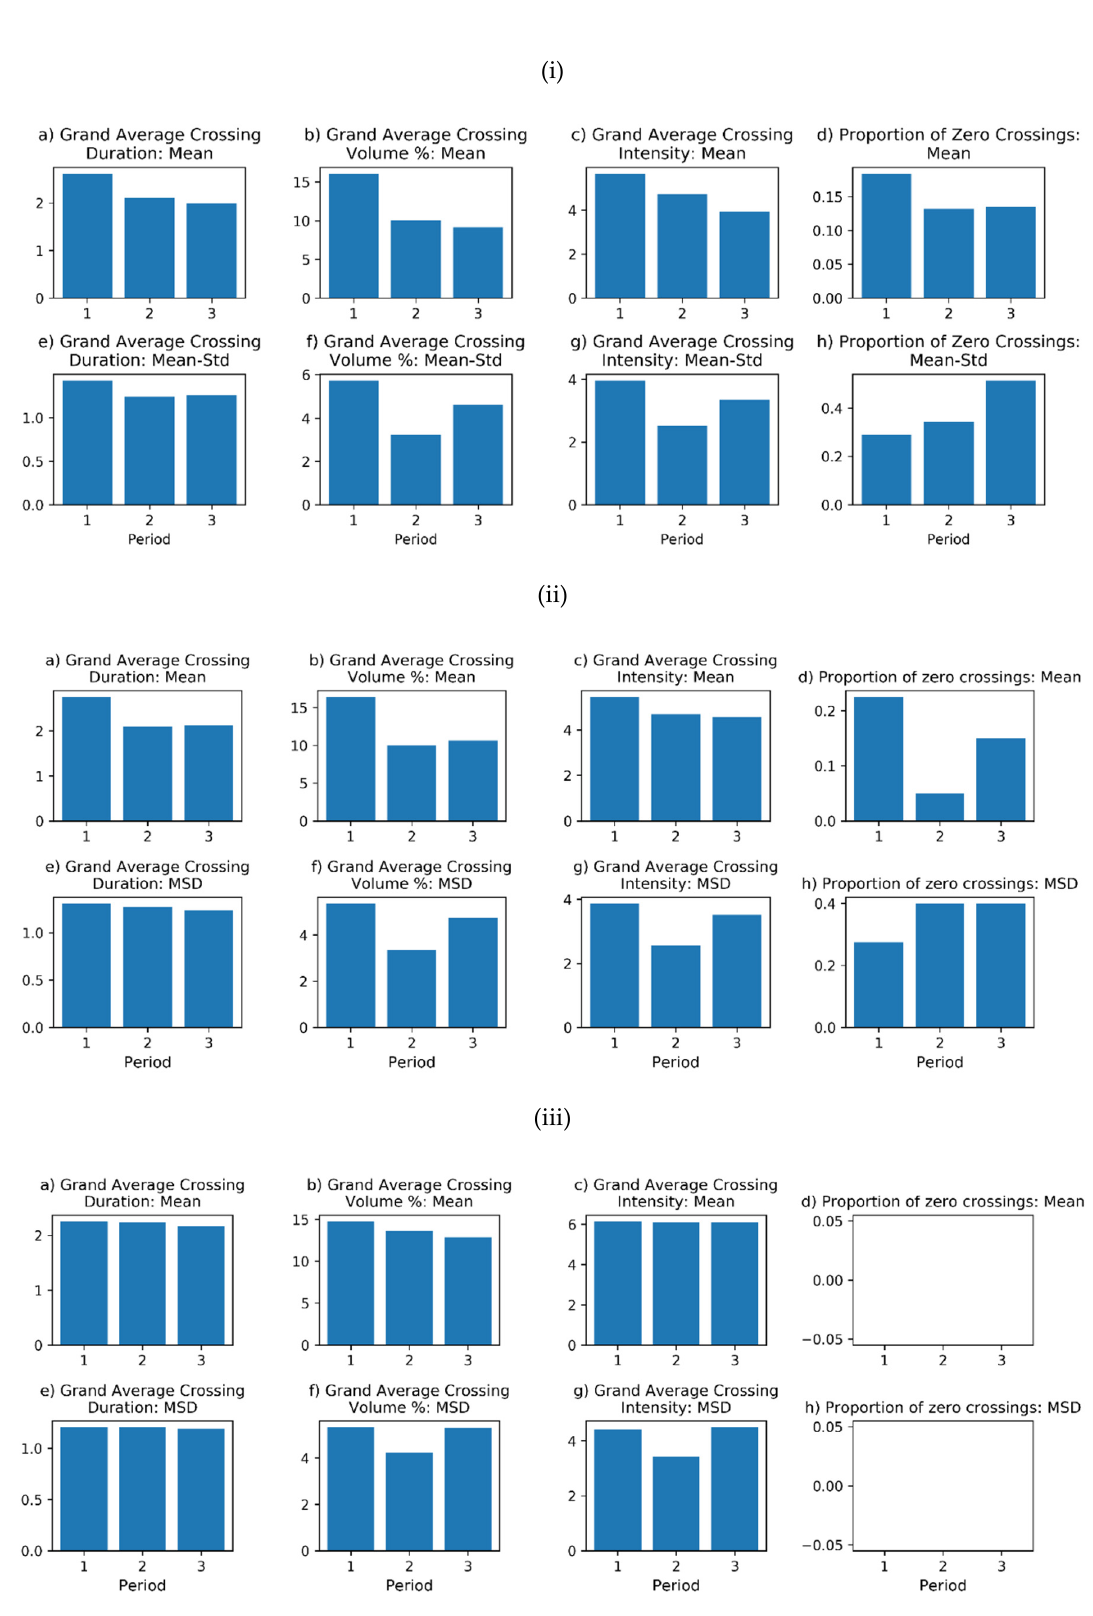
Figure 13. Plots of grand averages of the crossing statistics D , SV and I taken across regions and Periods 1–3 for the mean crossing level ( a – c ) and MSD level ( e – g ). The proportion of years in which no crossing event occurred across the set of regions is also shown ( d , h ). (i) For the 8 LTP regions and the 1900–2013 data set; (ii) for the 8 LTP regions and the extended 1900–2020 dataset; (iii) for all 19 regions and the extended 1900–2020 data set. (Note, different vertical